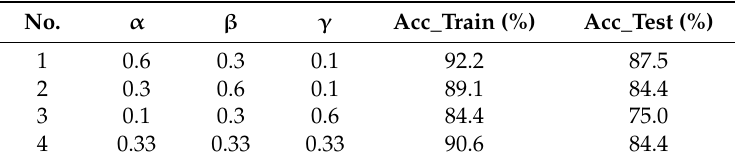
Table 3. The classification accuracy of different weighted